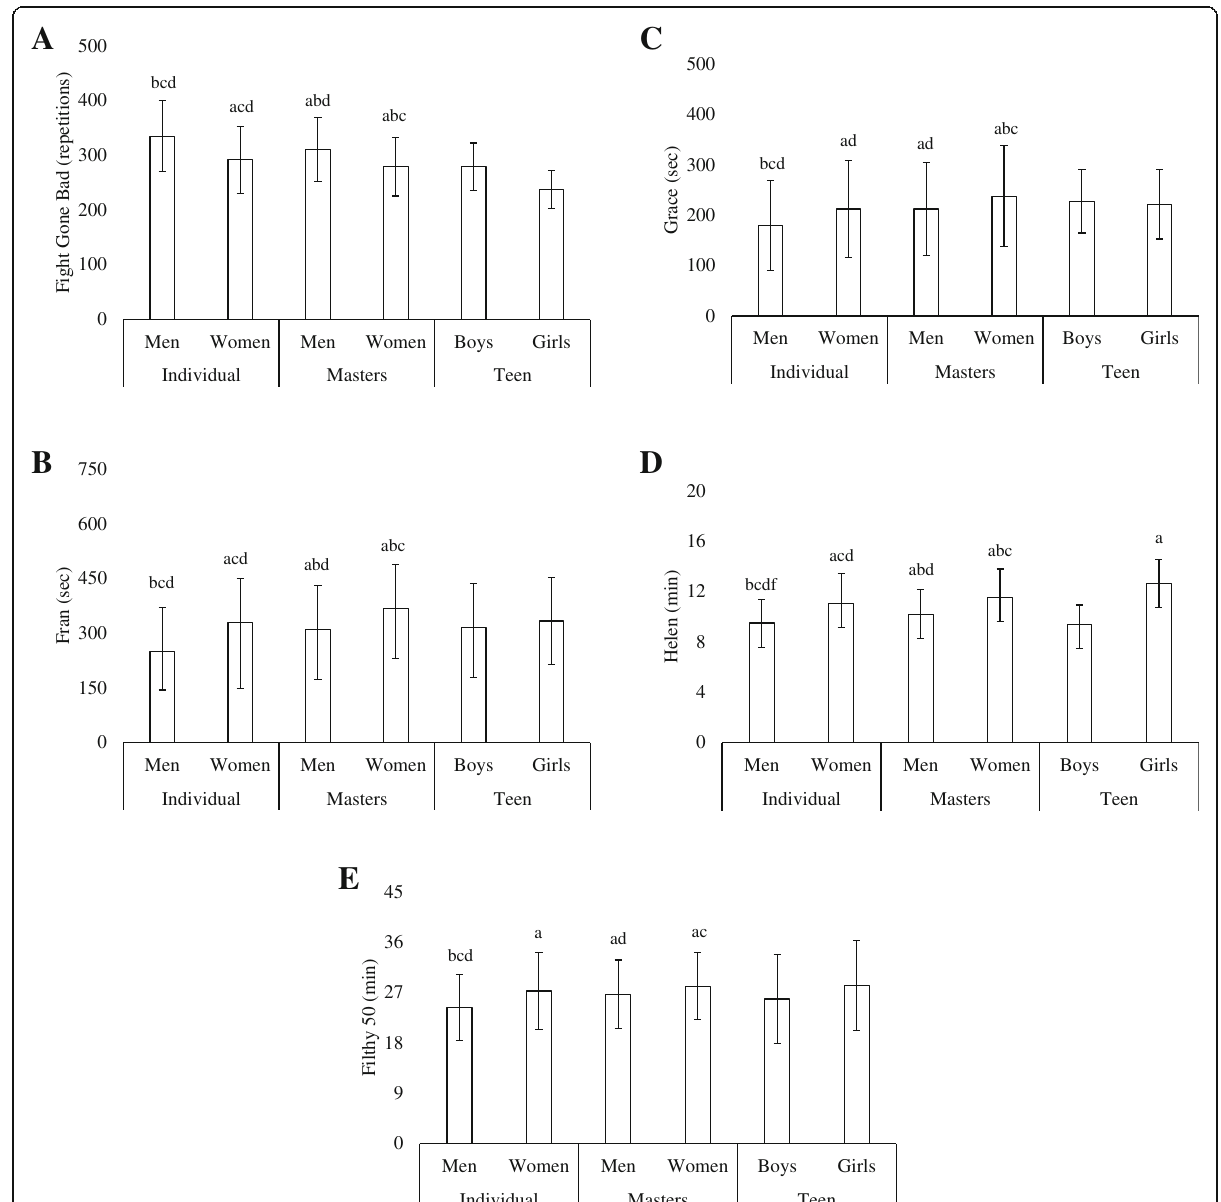
Fig. 1 Comparisons between competitive age-classifications and sex in common benchmark workouts ( A . Fight Gone Bad; B . Fran; C . Grace; D . Helen; E . Filthy 50). a . Significantly ( p <0.05) different from individual men. b . Significantly ( p <0.05) different from individual women. c . Significantly ( p <0.05) different from master ’ s men. d . Significantly ( p <0.05) different from master ’ s women. e . Significantly ( p <0.05) different from teen boys. f . Significantly ( p <0.05) different from teen